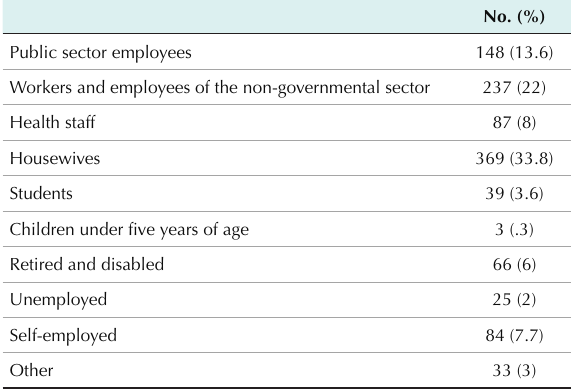
Table 2. Distribution of COVID-19 Cases in Occupational Groups